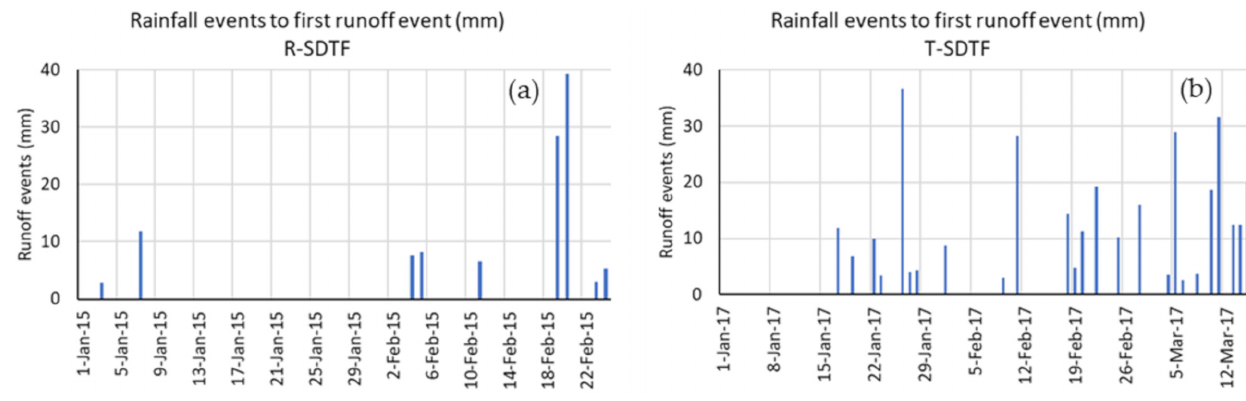
Figure 8. Rainfall events leading to first runoff event in the dry years 2015 ( a ) and 2017 ( b